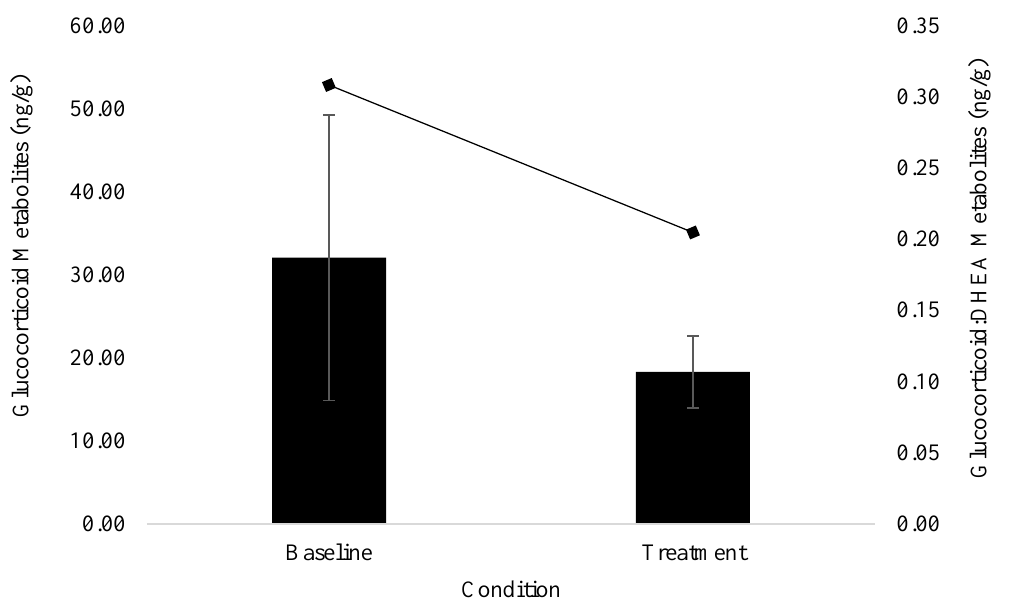
Results Examining Changes in Adrenal Activity after Restricting Viewing Access